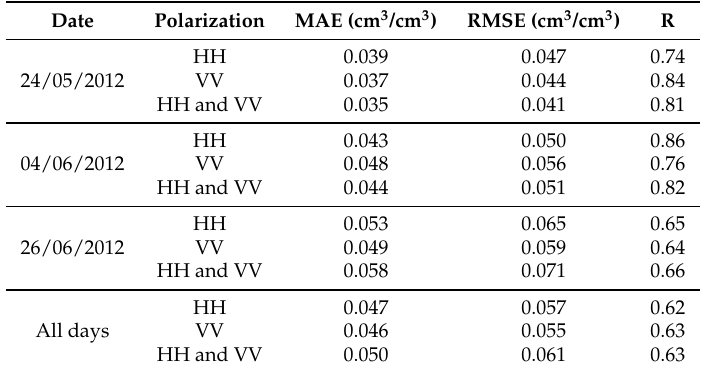
Table 8. The MAE, RMSE and R of SSM retrieved by WC-EM combined with ANN in each and all